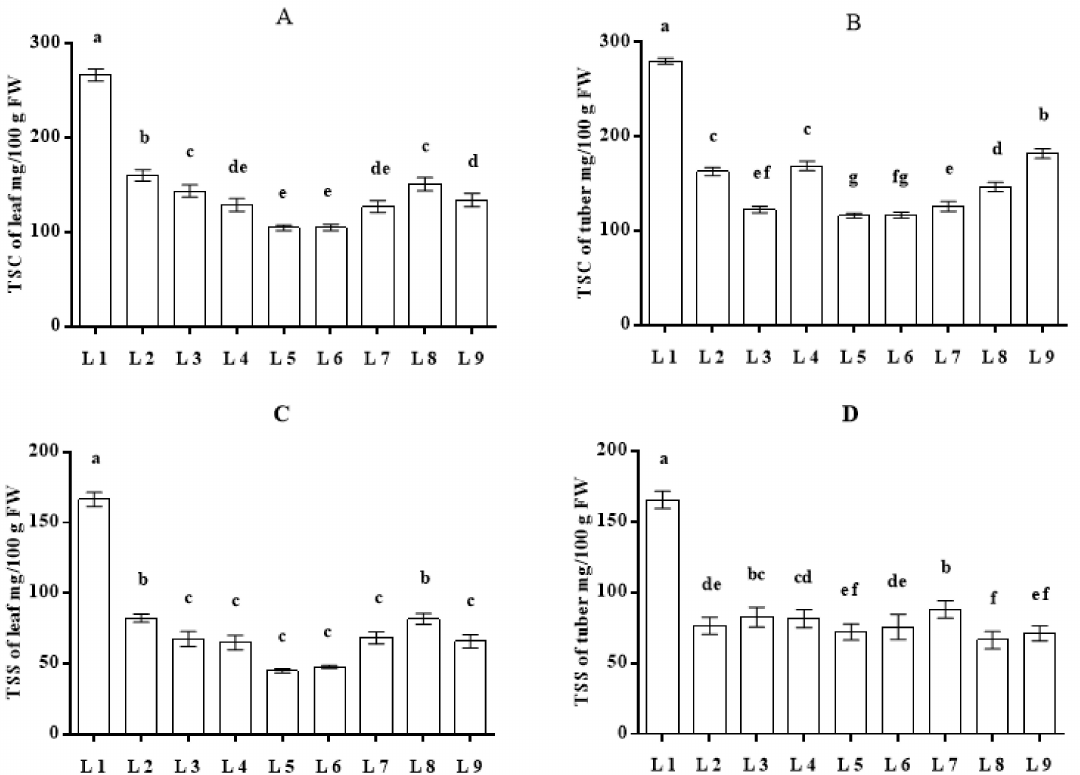
Figure 5. Effect of LED light on TSC of leaf ( A ), TSC of tuber ( B ), TSS of leaf ( C ), and TSS of tuber ( D ) grown under aeroponic system. Different letters indicate significant differences ( p ≤ 0.05) among the treatments within each parameter. Each value represents the mean ± SD (n = 3). L1 = natural light, L2 = R:B, L3 = R:B:G, L4 = R:B:FR, L5 = R:B:G:FR, L6 = R:B:G:FR:UV, L7 = R:B:FR:UV, L8 = R:B:W:FR, L9 =